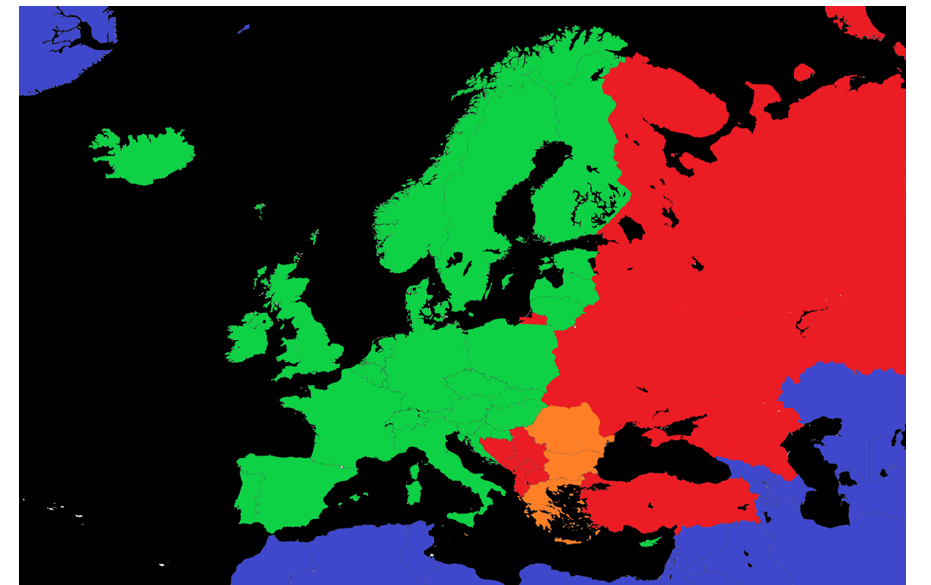
Figure 2. Emission domain and choice of data source for each country. Green: reported data; orange: reported data with significant correc- tions or gap-filling; red: GAINS emissions; blue: countries outside of UNECE-Europe. Gridded emissions from EDGAR-v4.3.2 inserted for these